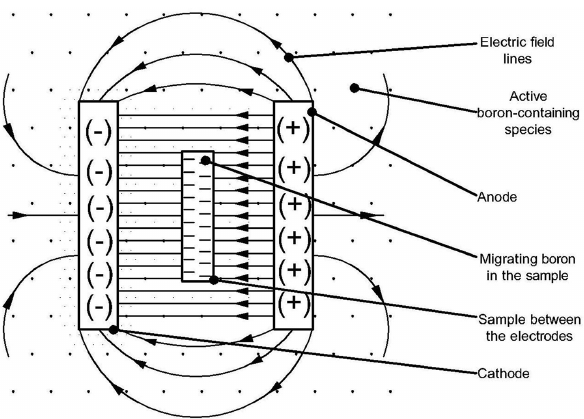
Figure 4: Schematic representation of boron mobility and electric field lines during the PBDCF (Modified from Xie et al . [8]).